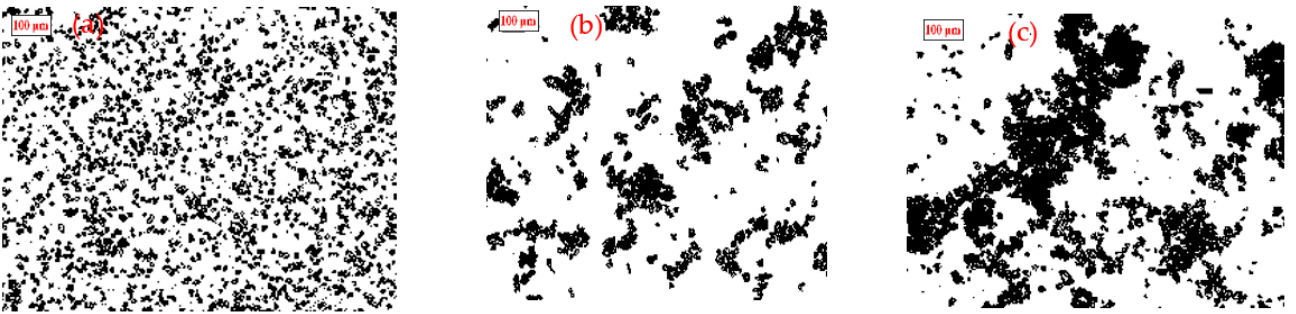
Figure 7. Optical microscope image of − 37 + 10 μ m cassiterite in the presence of BHA ( a ) and NaOL after stirring at 1300 r/min for 20 min ( b ) and 60 min ( c ).